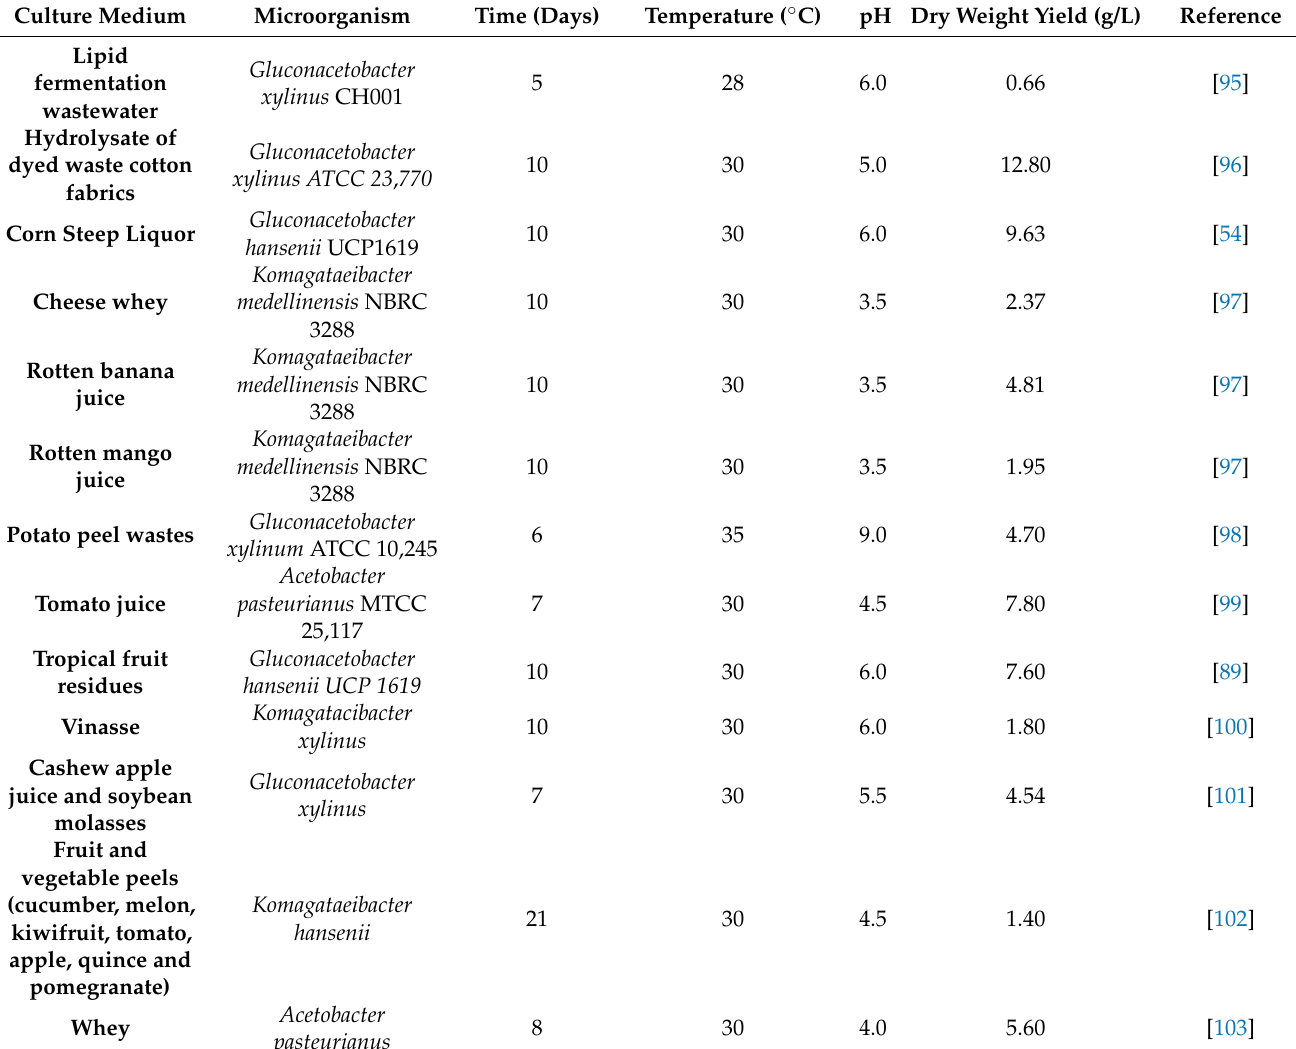
Table 2. Culture conditions found in the literature on bacterial cellulose production using agroindustrial wastes as low- cost